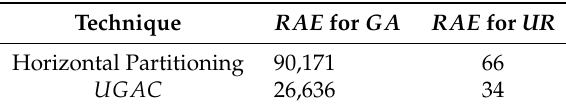
Table 3. Relative association error (RAE) for GA and UR